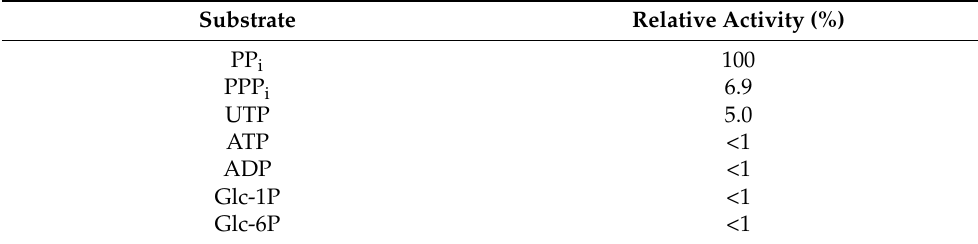
Table 2. Substrate specificity of